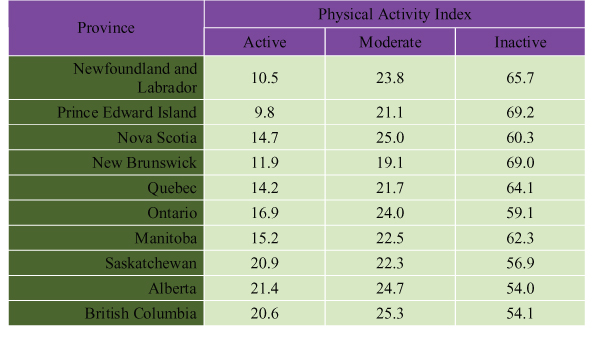
Percentage of Canadian Women from Each Province in Each Physical Activity Category Source: Statistics Canada, NPHS, 1996–1997